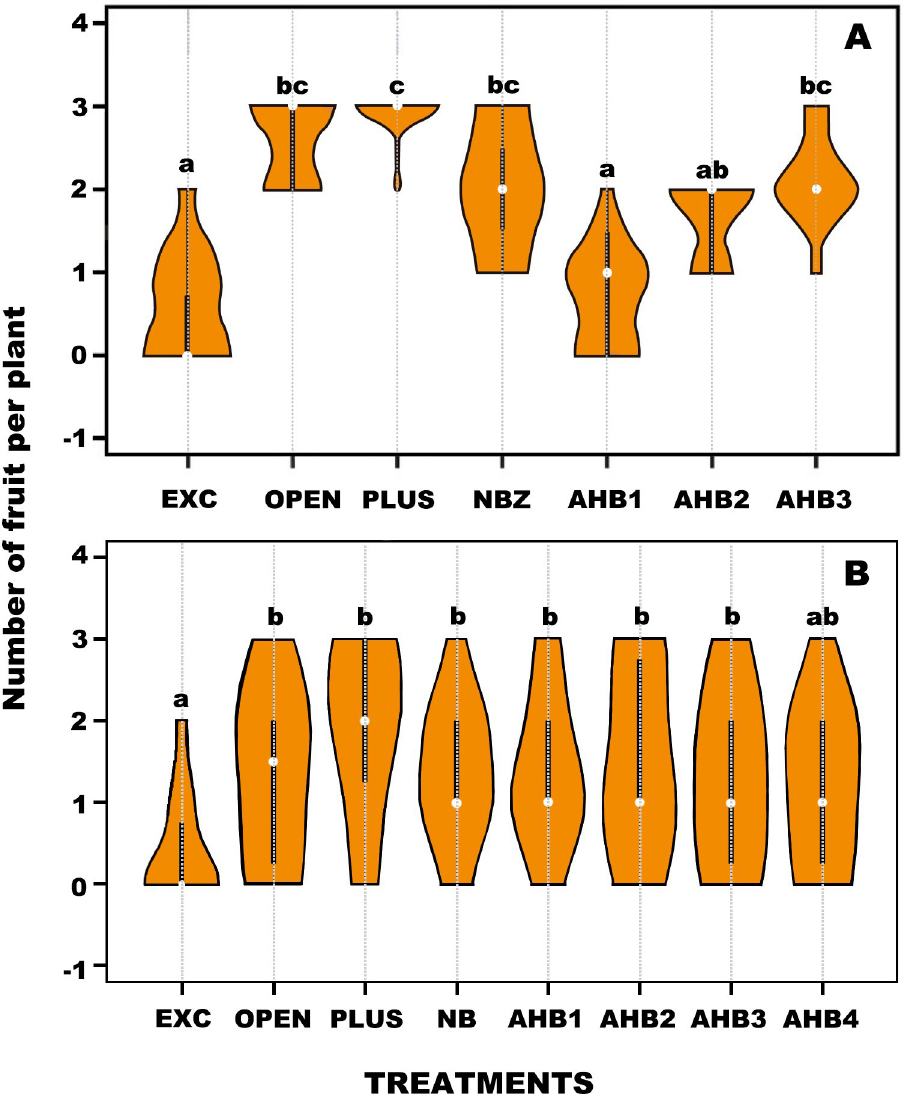
Fig 5. Violin plots of number of fruits produced in A) eggplant and B) annatto after the application of treatments for controlled flower access (see text for acronyms). White circles show the medians; box limits indicate the 25th and 75th percentiles. Different letters indicate significant differences among treatments at p <